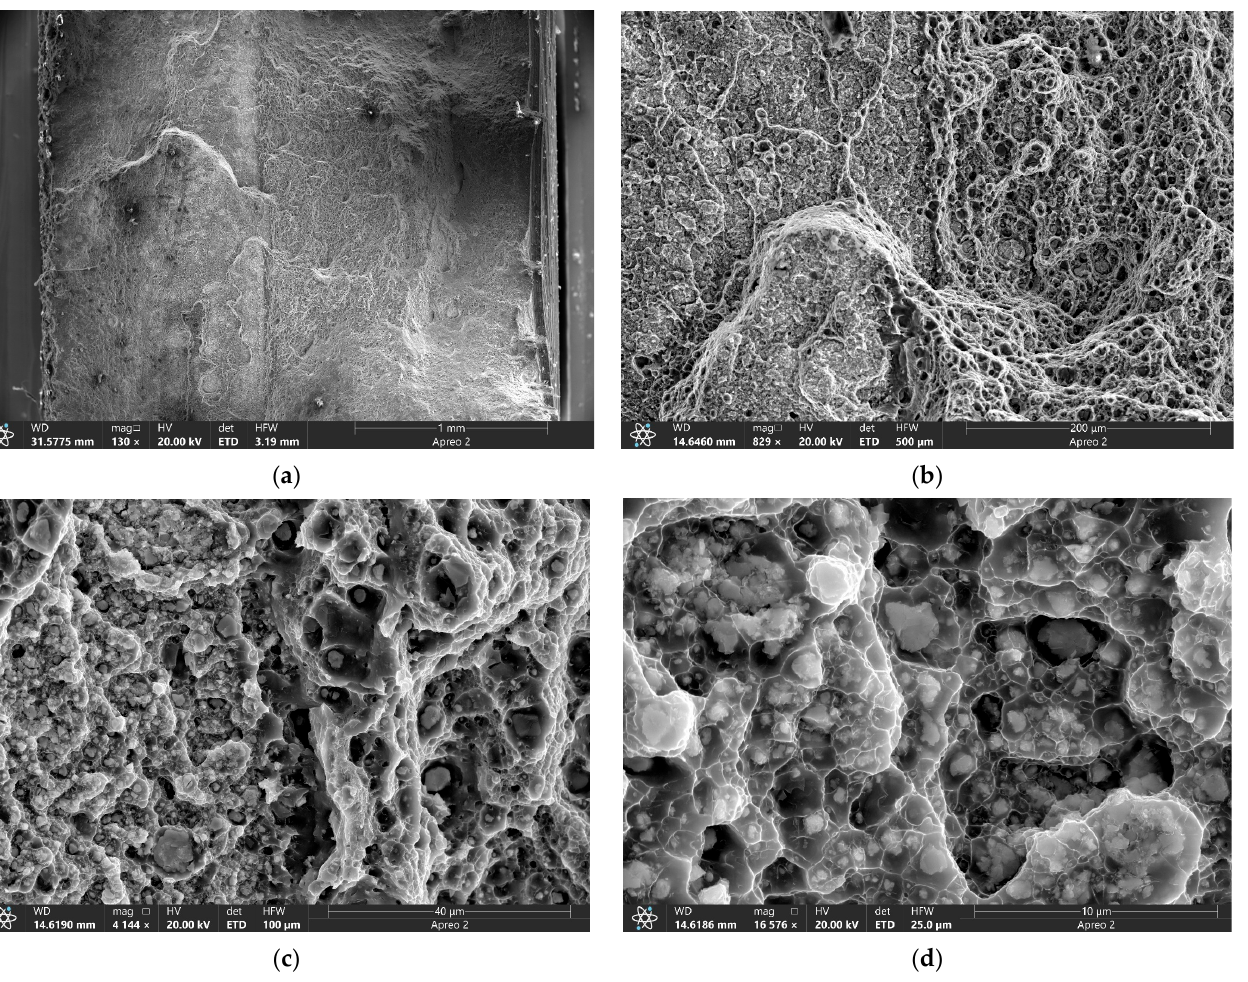
Figure 19. SEM BSE images of the tensile test fracture surfaces of the FSP-ed RPPs/AA5056 composite after 8 passes ( a – d ).